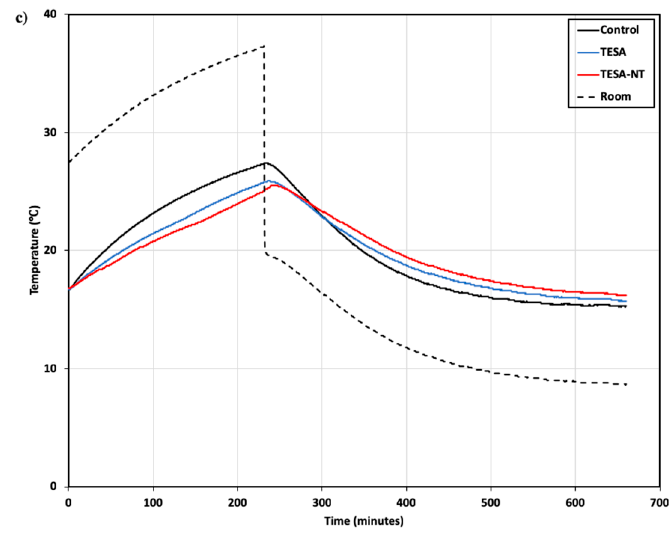
Figure 5. Thermal performance test results, a) in the center of the test room, b) at the inner and c) outer surfaces of the concrete panel.